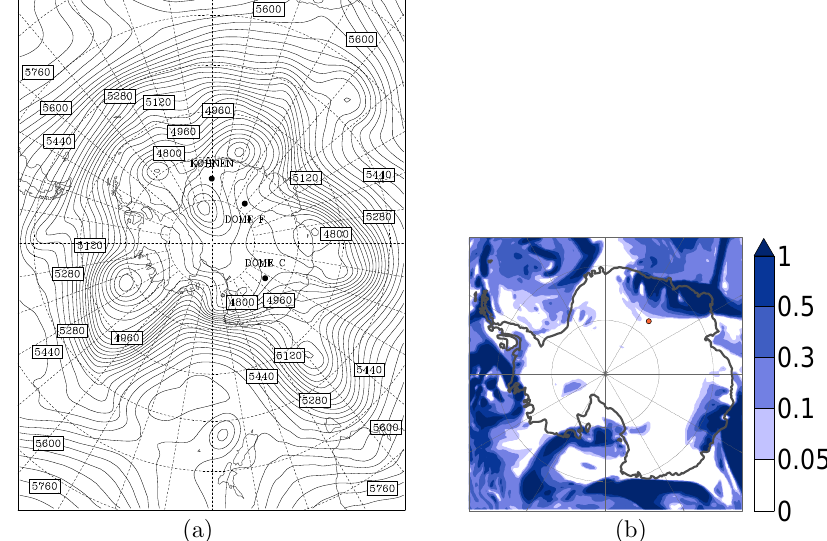
Figure 6. Example of a weak high-pressure ridge: (a) 500hPa geopotential height from AMPS, 13 August 2003 12:00UTC, (b) 6h precipi- tation in mm from AMPS, 14 August 2003